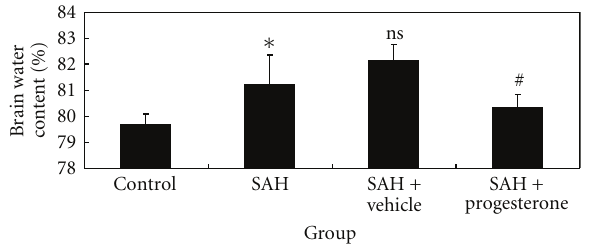
Figure 5: Alterations in brain water content in control group ( n = 6), SAH group ( n = 6), SAH + vehicle group ( n = 6), and SAH + progesterone group ( n = 6). The brain water content was increased significantly at 48 h after SAH. The progesterone treatment markedly reduced brain water content. No di ff erence of brain water content was detected between SAH and SAH + vehicle groups ∗ P < . 05 versus control group, # P < . 05 versus SAH + vehicle group, ns P > . 05 versus SAH group.